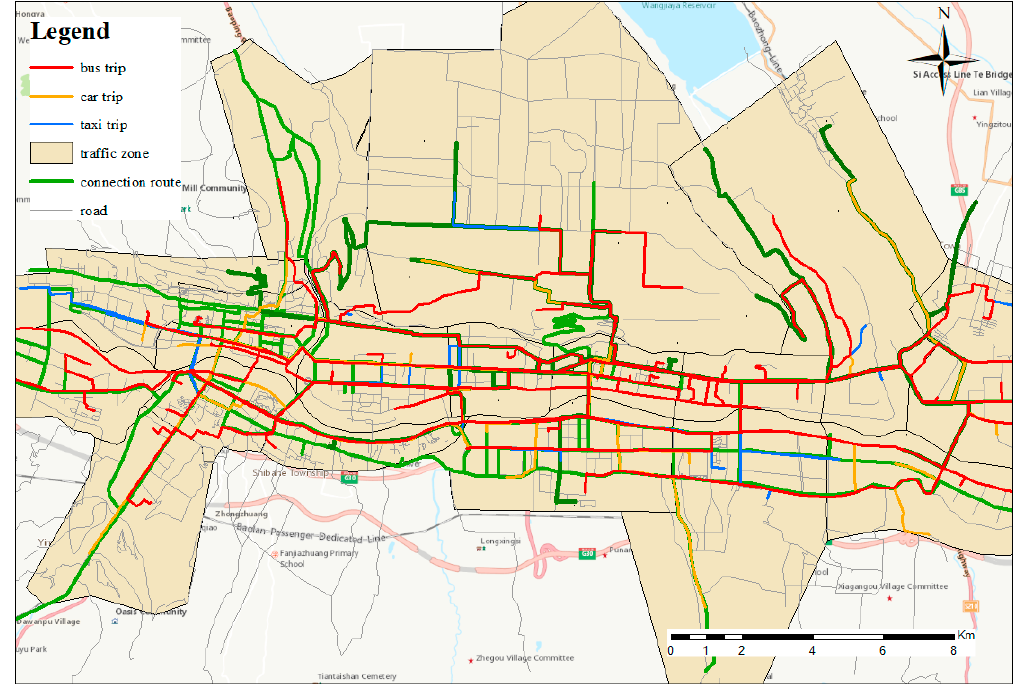
Figure 2. Origin-destination (OD) routes for individual by bus, car, and taxi.